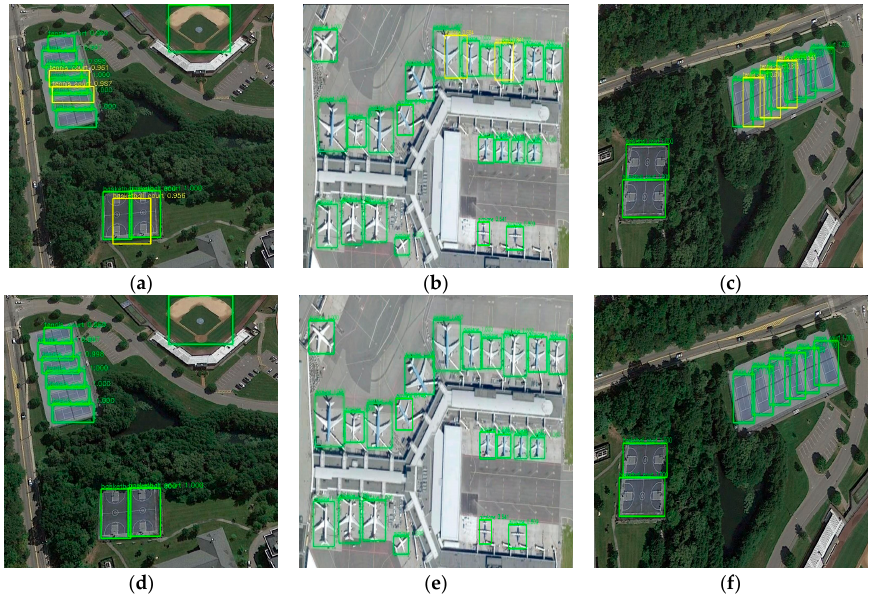
Figure 8. Detection results using our method with NMS and Soft NMS. The first row are results